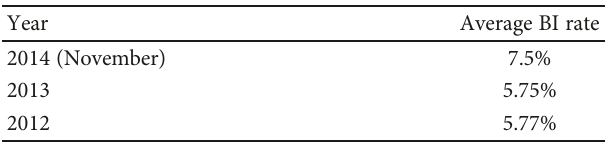
Figure 7: Indonesia in fl ation rate. Source: http://www.tradingeconomics.com. Table 3: Comparison of life cycle cost between the concrete and Table 2: History of BI rate in 2011 – PV rooftop.